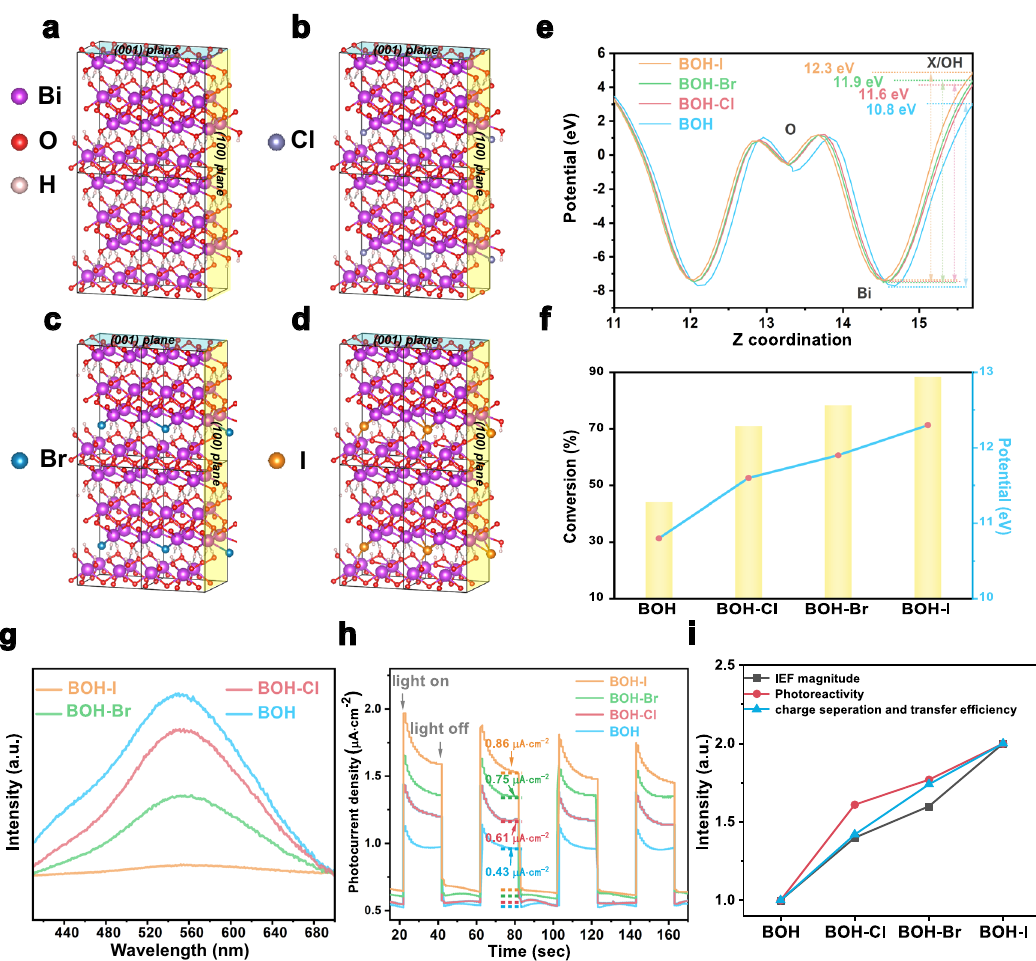
Fig. 6 Structure-activity relationship of BOH and BOH-X. a – d Crystallographic structures for BOH, BOH-Cl, BOH-Br, and BOH-I. e DFT calculated the local internal electric fi eld for the four catalysts. f Superimposed plots of benzylamine conversion (the yellow columns) and calculative IEF intensity (the red dots) for the four catalysts. g Steady photoluminescence spectra (excitation wavelength: 346 nm). h The photocurrent density spectra (solvent: acetonitrile; bias: 1.25 V). i The comparison of charge separation and transfer ef fi ciency, IEF and photoactivity for samples (assuming all the values of BOH to be “ 1 ” ).